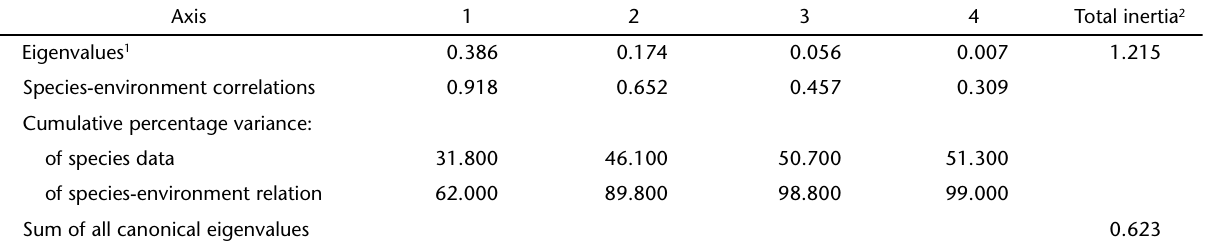
Table II. Canonical correspondence analysis (CCA) summary showing the correlation between environmental descriptors and the abundance of nektonic species. All four reported eigenvalues are canonical and correspond to axes that are constrained by environmental variables.